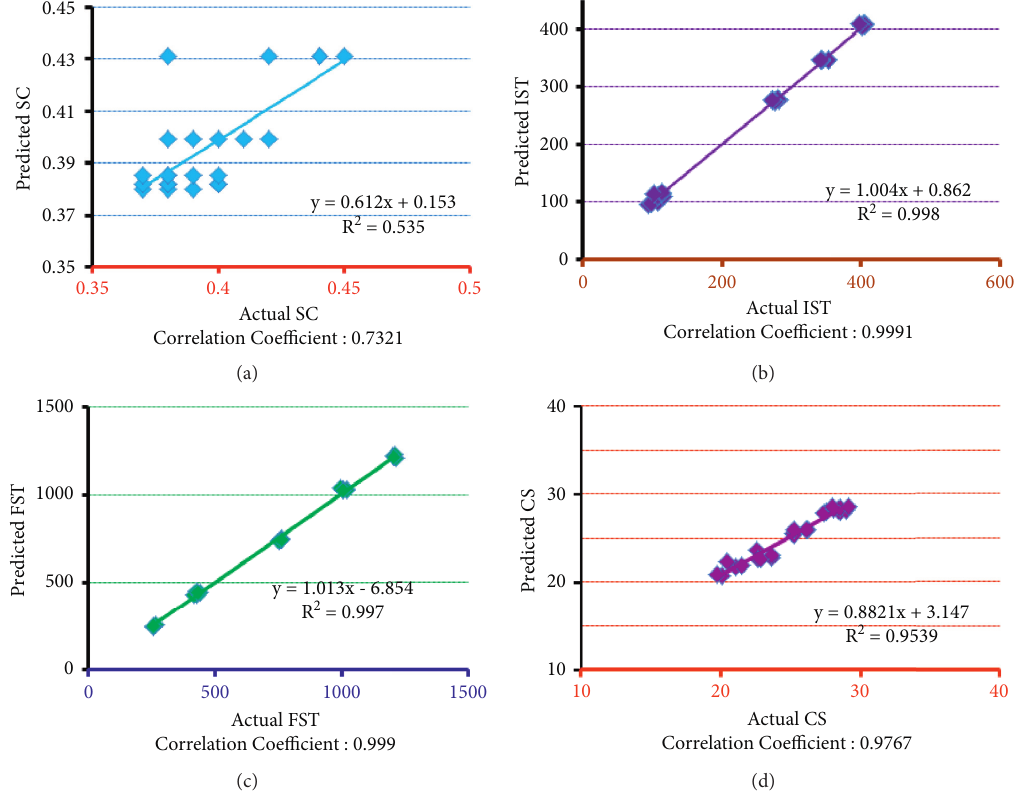
Actual FST Correlation Coefficient :